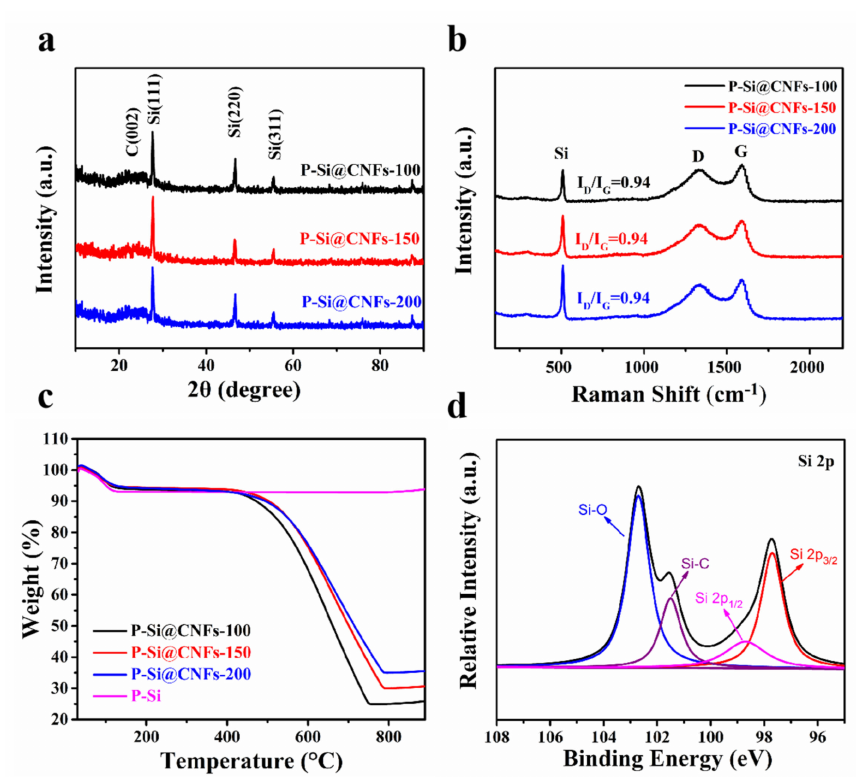
Figure 1. ( a ) XRD pattern, ( b ) Raman spectra, and ( c ) TGA curves of P − Si@CNFs − 100, 150, and 200 in air, and ( d ) high − resolution spectrum of Si 2p of P − Si@CNFs −